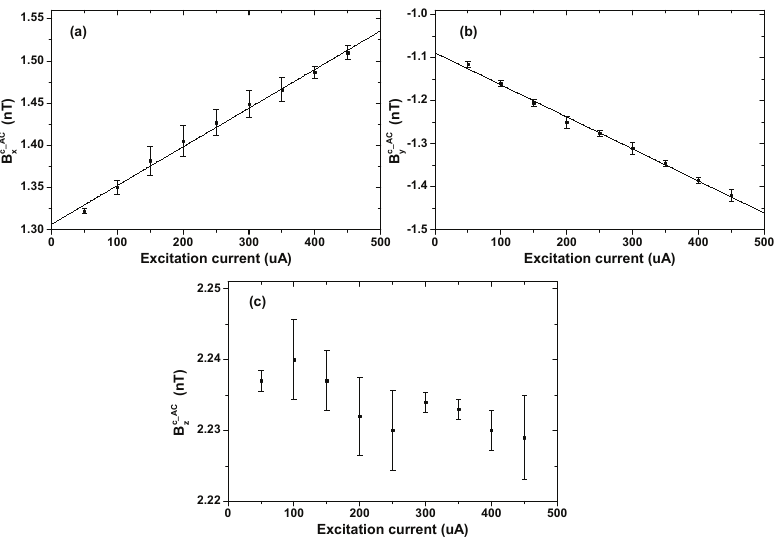
Figure 5. Three-axis components of B c_AC as a function of the excitation current of the Pt1000 sensor. B c_AC = ( B c_AC x , B c_AC y , B c_AC z ) . ( a ) B c_AC x , ( b ) B c_AC y , ( c ) B c_AC z . The lines that overlay the data is a linear fitting. The intercepts of the fitting results in ( a ) and ( b ) is 1.31 nT and − 1.09 nT, respectively. The uncertainty of each measurement value is less than 0.02